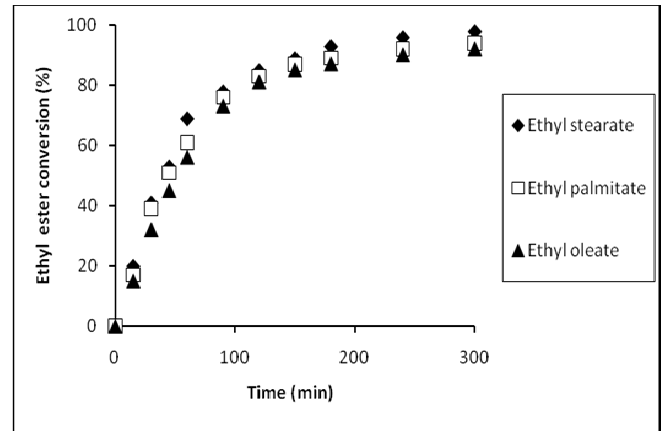
Figure 4. Conversion profiles of the esterification of stearic, palmitic and oleic acid with ethanol over 0.1 w/w KSF/0 catalyst at 150